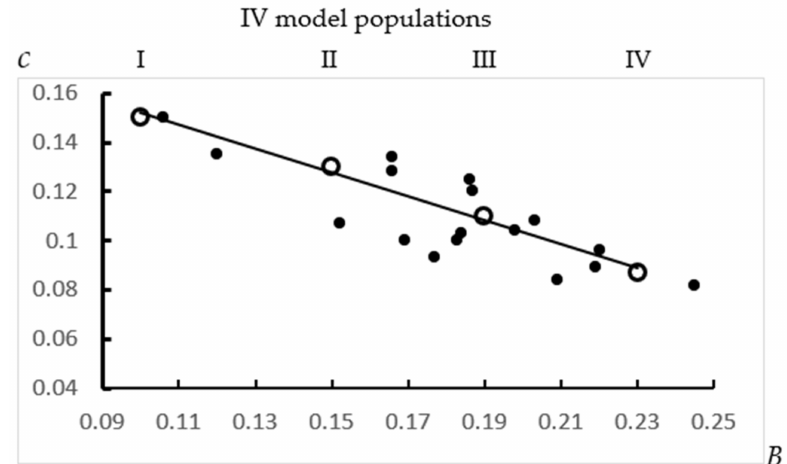
Figure 2. Correlation between the values of parameters B and c, found in the analysis of cow culling rate in 15 production units of Leningrad oblast (total size of whole population ≈ 35,000 dairy cows). —model forecast for IV model populations with the same values of c = 0.15; I is homogenous, II consists of two, III and IV consist of three subpopulations, with different values of B and N 1 (initial number of cows in cohort) (Table 3). Table 3. Input data for four model populations (MP) *. Parameters of MP Parameter B for Subpopulations Nr N 1 (Initial Number of Cows in Cohort) B c 0.1